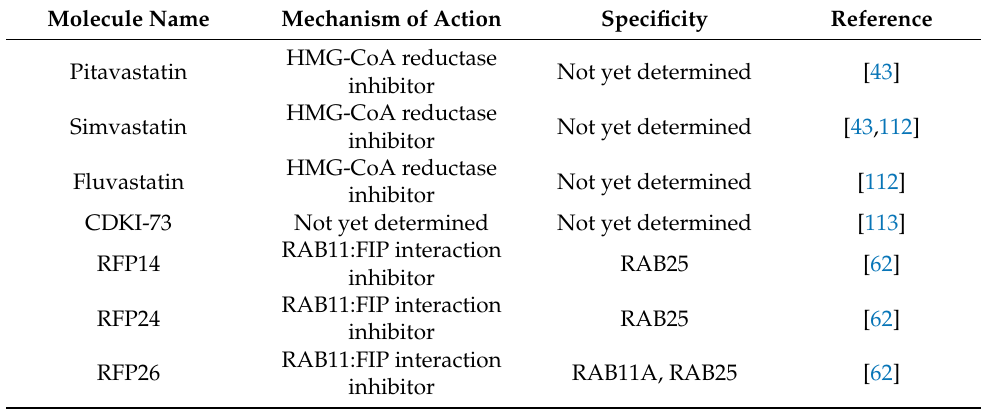
Table 5. Inhibitors of RAB11-mediated trafficking